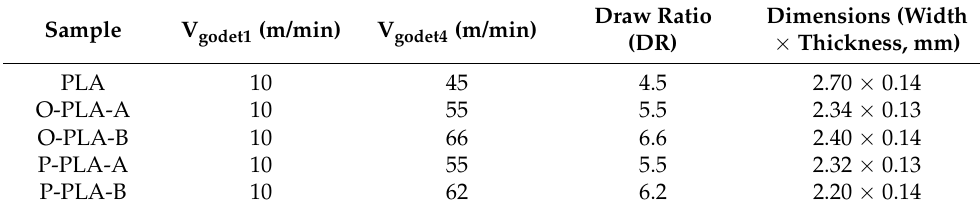
Table 2. Melt extrusion conditions for flat tape processing using monofilament melt spinning